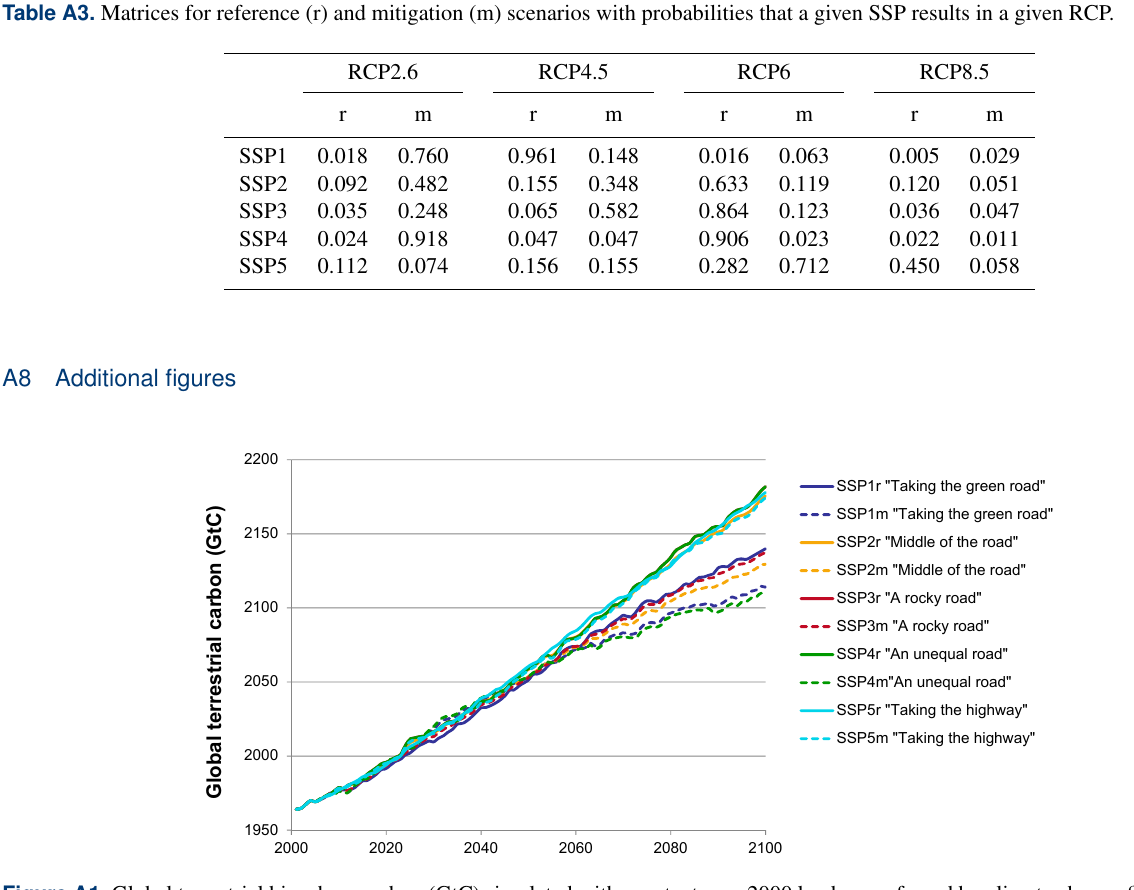
Earth Syst. Dynam., 8, 773–799,